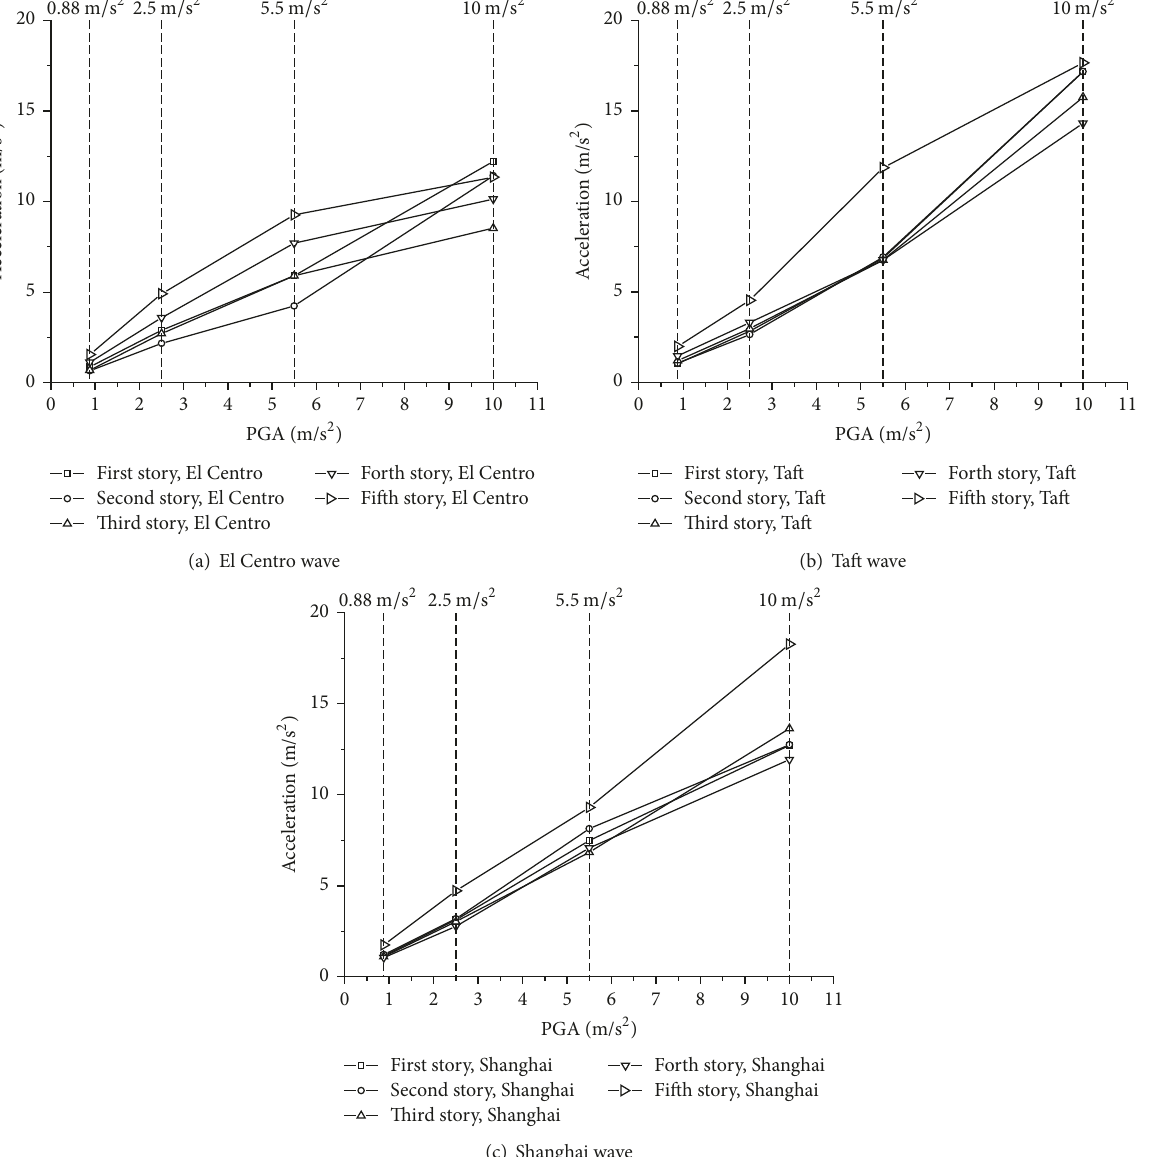
Figure 11: Story acceleration versus target PGA of SMS